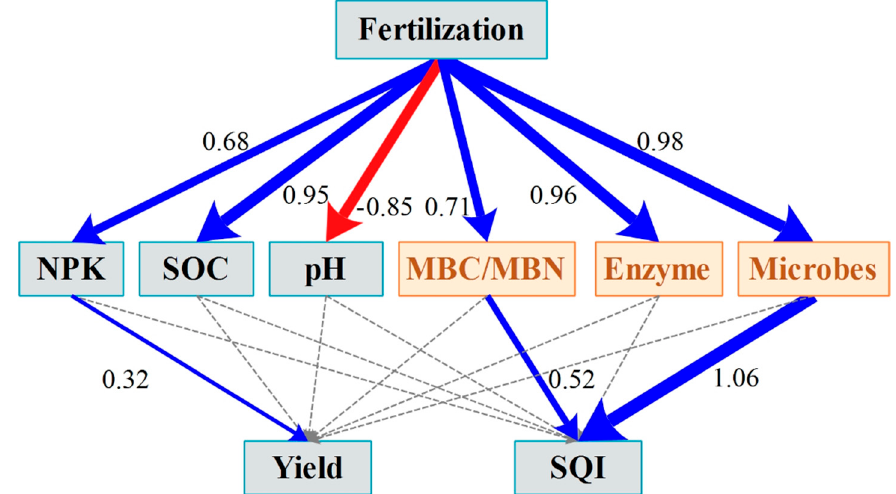
Figure 8. Partial least squares path model (PLS-PM) showing the multivariate effects on SQI and crop yield. Solid blue and red arrows represent significant ( p < 0.05) positive and negative paths, respectively; arrow widths denote the magnitude of these effects. Dashed lines indicate nonsignificant ( p > 0.05) pathways. Numbers near the lines represent the standard path coefficients. The model was assessed using the Goodness of Fit (GoF) statistic; the GoF value was 0.77. Notes: NPK: soil nutrient (total N; available N; available P; available K); SOC: soil organic carbon; Enzyme: enzyme activity; Microbes: microbial community; SQI: soil quality index.